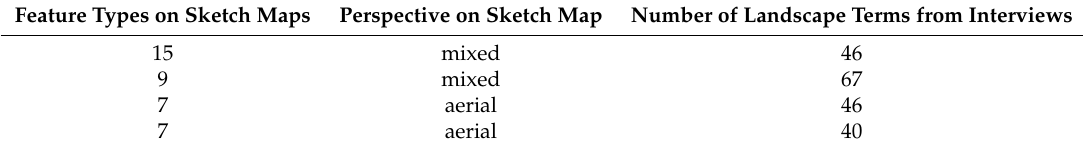
Table 2. Direct comparison of features from sketch maps and interviews for four